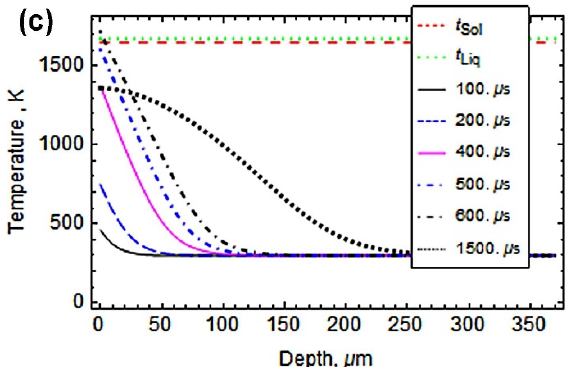
Figure 7. Temperature field dynamics in the specimen of steel 316L after contacting with the plasma pulse: ( a ) layer-by-layer temperature change, ( b ) layer-by-layer change in heating/cooling velocity, ( c ) depth-wise temperature change over time.